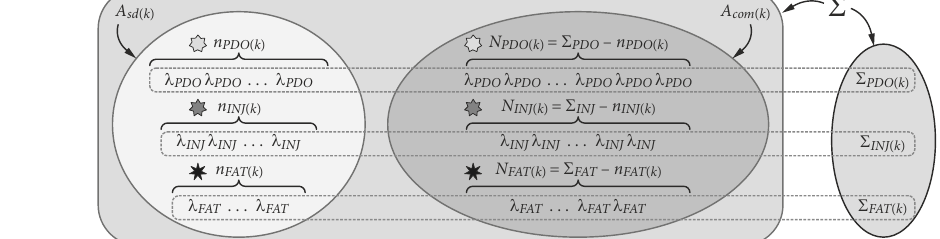
Fig. 1. Display of observed groups with traffic accidents